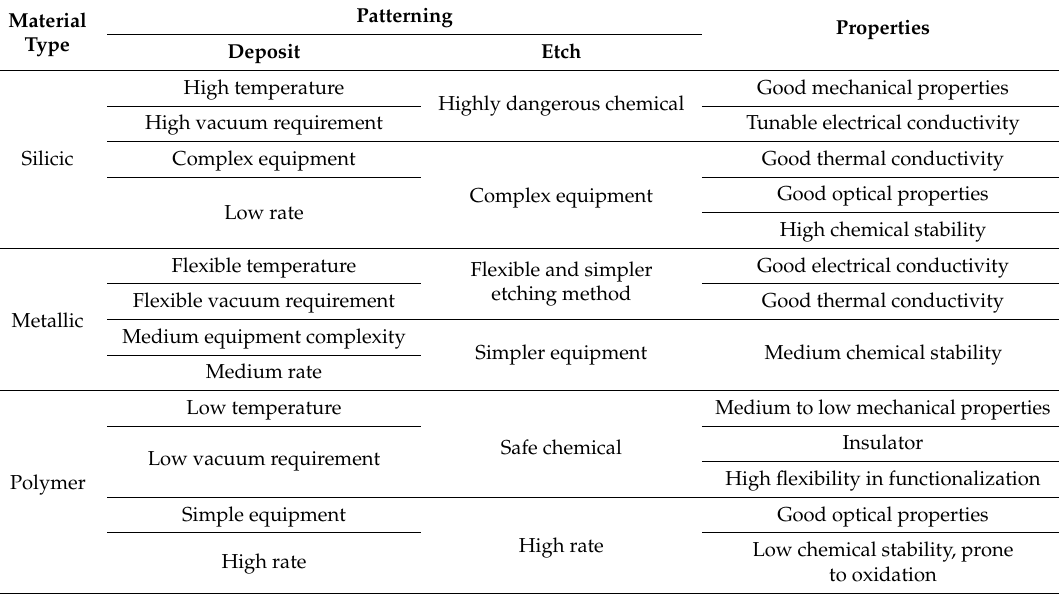
Table 2. Comparisons of tactile sensor material types.